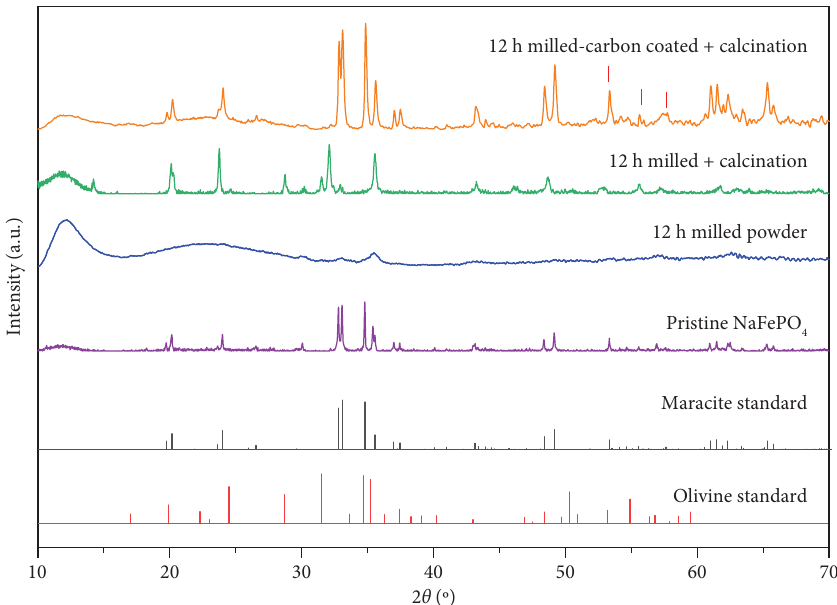
Figure 1: XRD pattern of 12h ground m-NaFePO 4 (before/after calcination) compared to the pristine